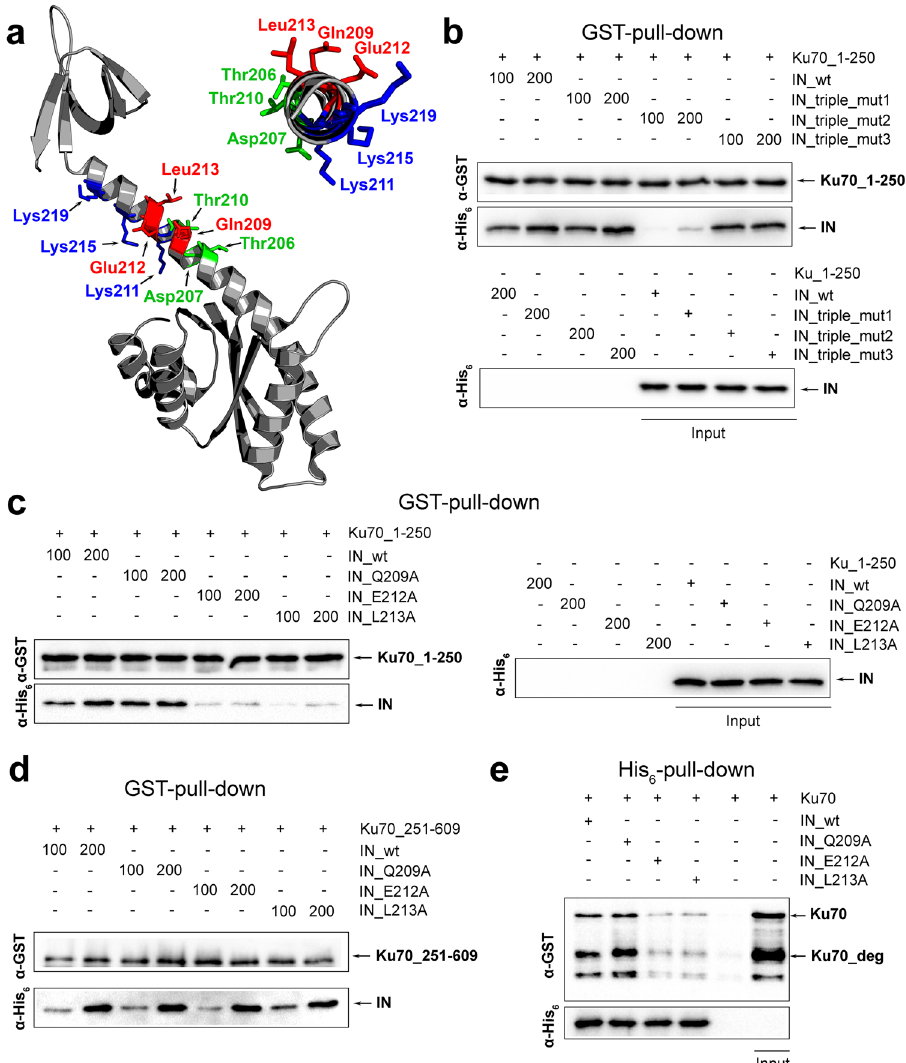
Figure 6. The influence of mutations in the 200–220 a.a. region of IN on its interaction with Ku70. ( a ) Structure of a two-domain region of IN (PDB ID: 1EX4); amino acid residues changed to alanine are marked by color. ( b ) GST-pull down assay analysis of the interaction between IN triple point mutants (100 and 200 nM) with Ku70_1-250 (100 nM). Cropped images are presented. Uncropped images are shown on Fig. S8. ( c ) GST-pull down assay analysis of the interaction between IN single point mutants (100 and 200 nM) with Ku70_1-250 (100 nM). ( d ) GST-pull down assay analysis of the interaction between IN single point mutants (100 and 200 nM) with Ku70_251-609 (100 nM). ( e ) His 6 -pull down assay analysis of the interaction between full-length Ku70 (200 nM) with IN single point mutants (100